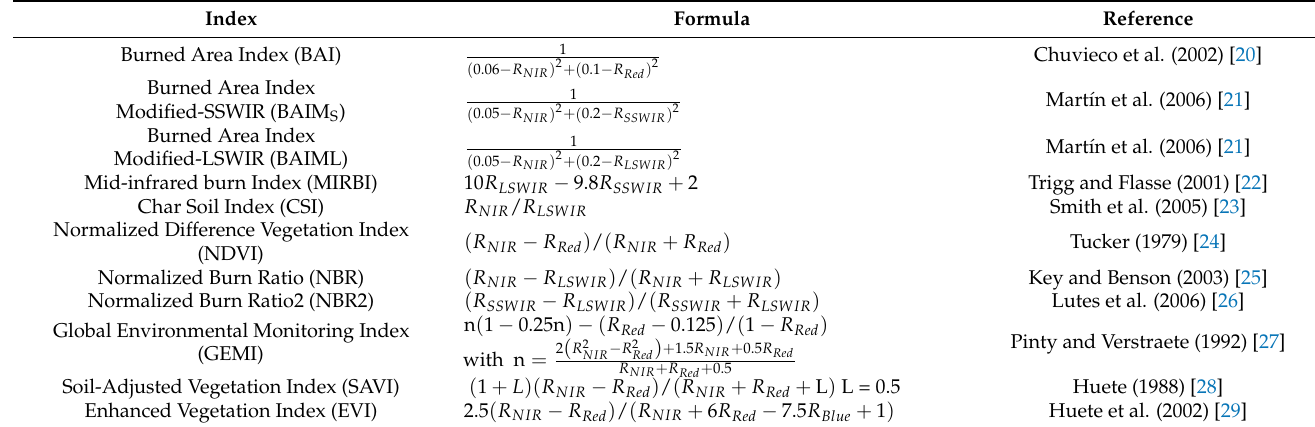
Table 2. Summary of spectral indices. R Blue , R Red , R NIR , R SSWIR , and R LSWIR corresponds to surface reflectance in blue, red, near-infrared, short shortwave infrared, and long shortwave infrared spectral bands, respectively. Index